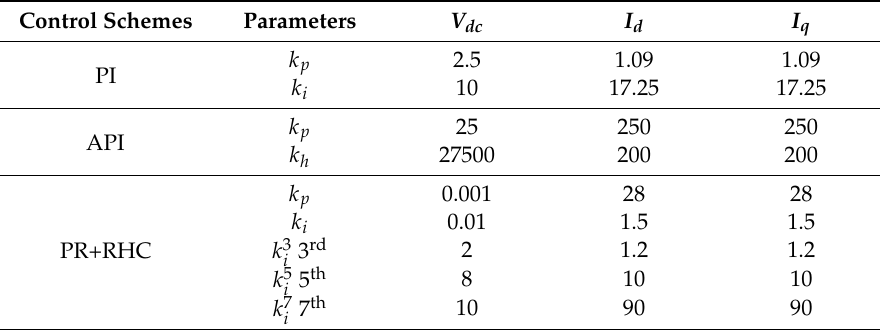
Table A2. Control schemes